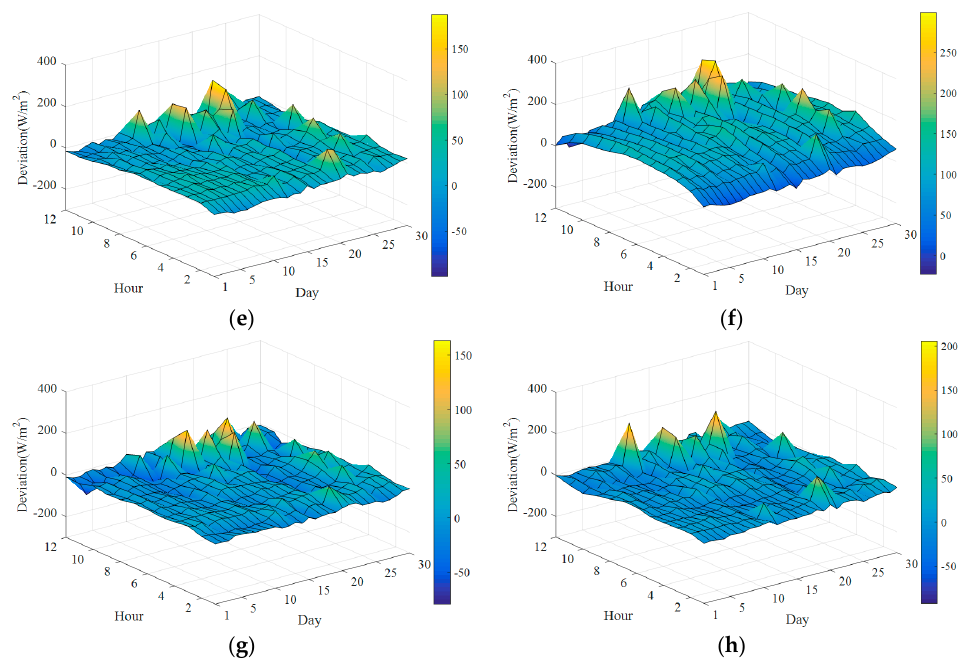
Figure 9. The deviation between actual and forecasted solar irradiance of different models. ( a ) WD level 0; ( b ) WD level; ( c ) WD level 2 ( d ); WD level 3; ( e ) WD level 4; ( f ) WD level 5; ( g ) Single fusion model; and, ( h ) Classified fusion models.